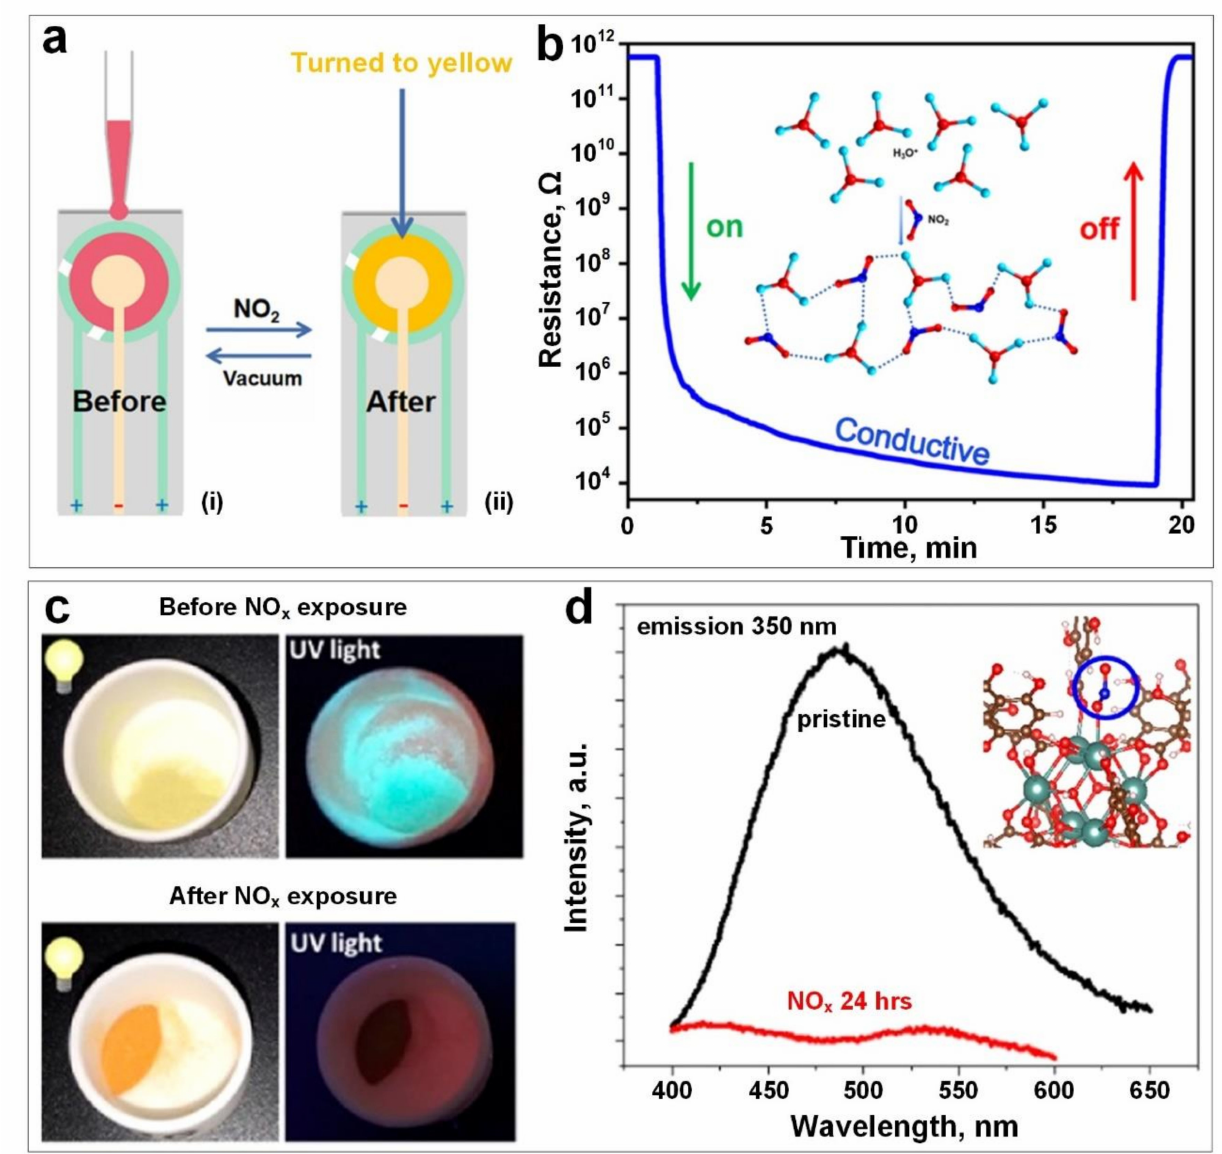
Figure 1. ( a ) The colour change in a gold electrode sheet covered by MOF A before and after NO 2 exposure. ( b ) The resistance variation versus time upon NO 2 exposure. Reproduced with permission from [85] American Chemical Society, 2021. ( c ) The colour change of Y-DOBDC before and after exposure to NO x under visible and UV light. ( d ) Photoluminescent intensity of Y-DOBDC before and after 24 h exposure to NO x , and the guest-framework interactions (Inset). Reproduced with permission from [32] American Chemical Society,